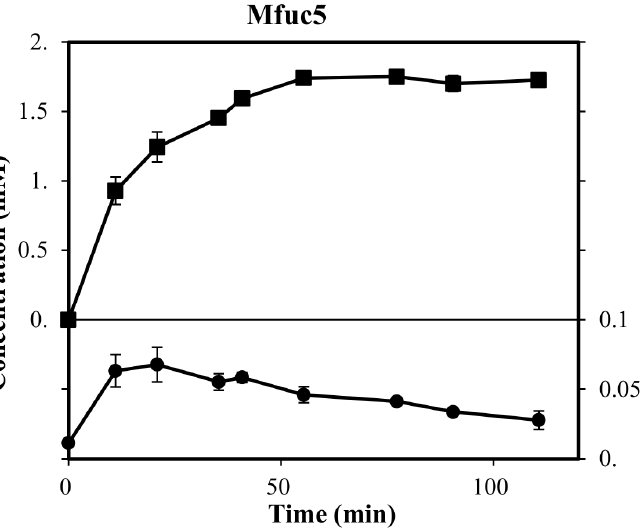
Fig 4. Time study of trans-fucosylation with xyloglucan as fucosyl donor catalyzed by Mfuc5. Reaction was done using 5.5 mM xyloglucan-bound fucose as donor and 140 mM lactose as acceptor at 30°C and pH 7. Concentration of L-fucose ( ■ ), and FL ( ● ) was determined by